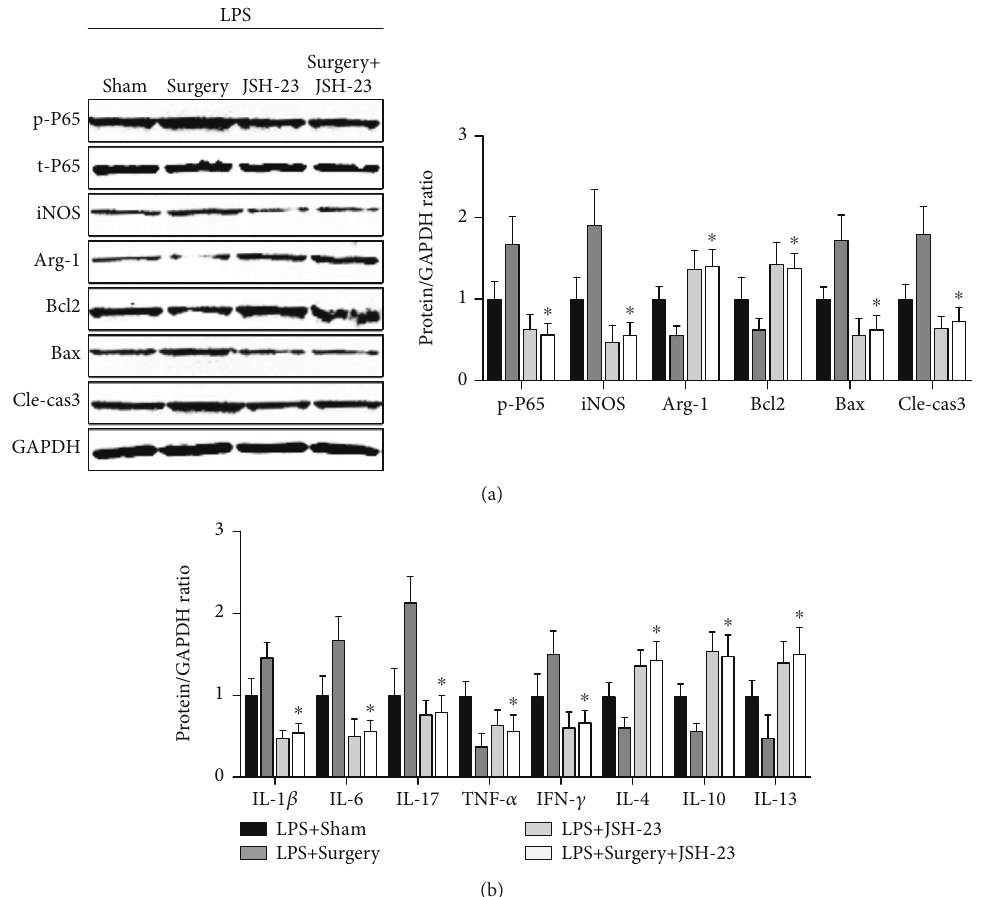
Figure 5: E ff ects of JSH-23 on LPS-induced cardiac injury. (a) p65 phosphorylation, iNOS, Arg-1, Bcl2, Bax, and Cle-cas3 levels were measured by western blot. (b) The IL-1 β , IL-6, IL-17, TNF- α , IFN- γ , IL-4, IL-10, and IL-13 mRNA levels in each group were detected by RT-qPCR. N = 5 in each group. ∗ P < 0 05 vs. the LPS+Surgery